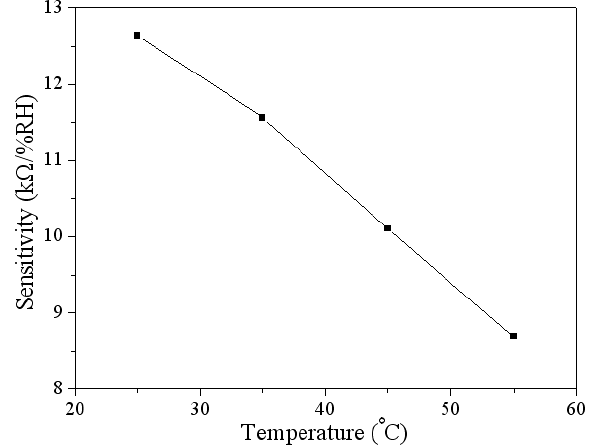
Figure 9. Relation between humidity sensitivity and